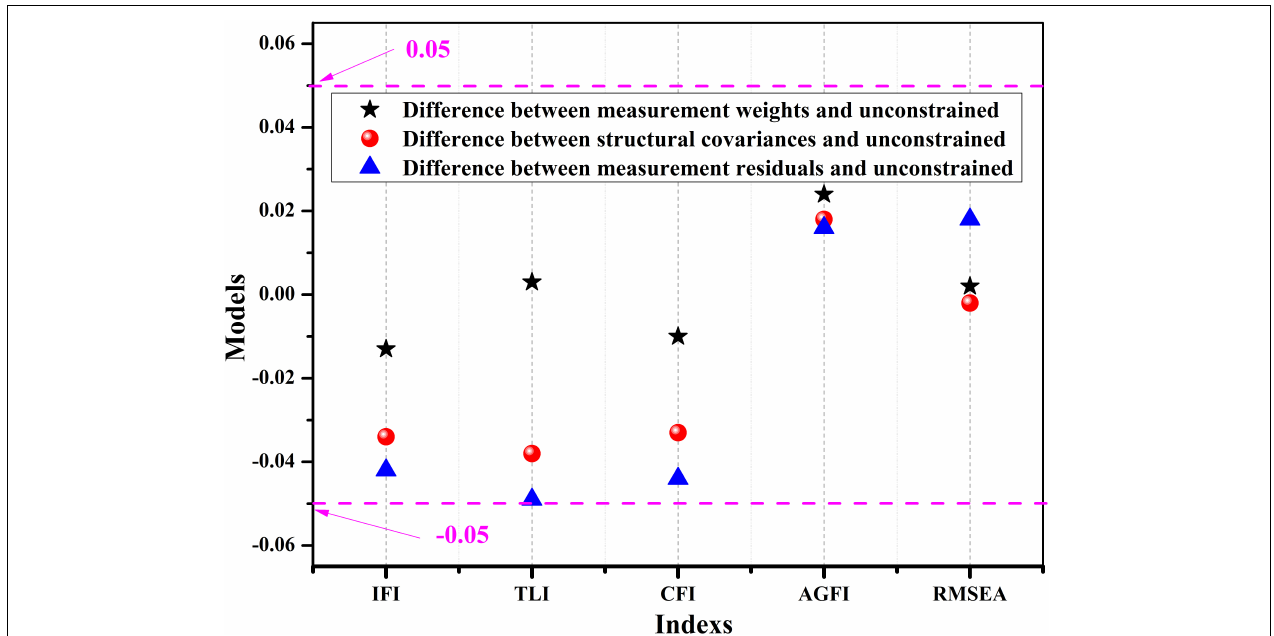
FIGURE 2 | Model invariant tests of adolescent drug abusers and non-abusers